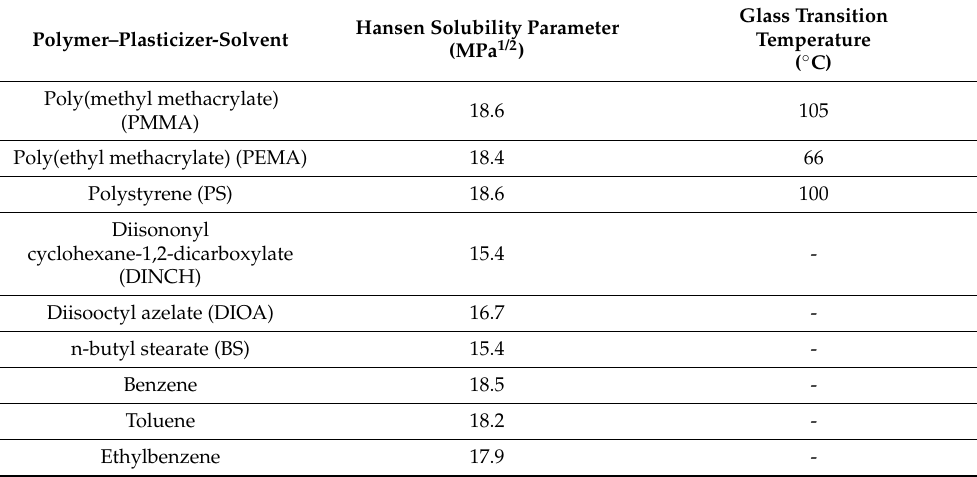
Table 3. Hansen solubility parameter and glass transition temperature of polymer and plasticizers used.